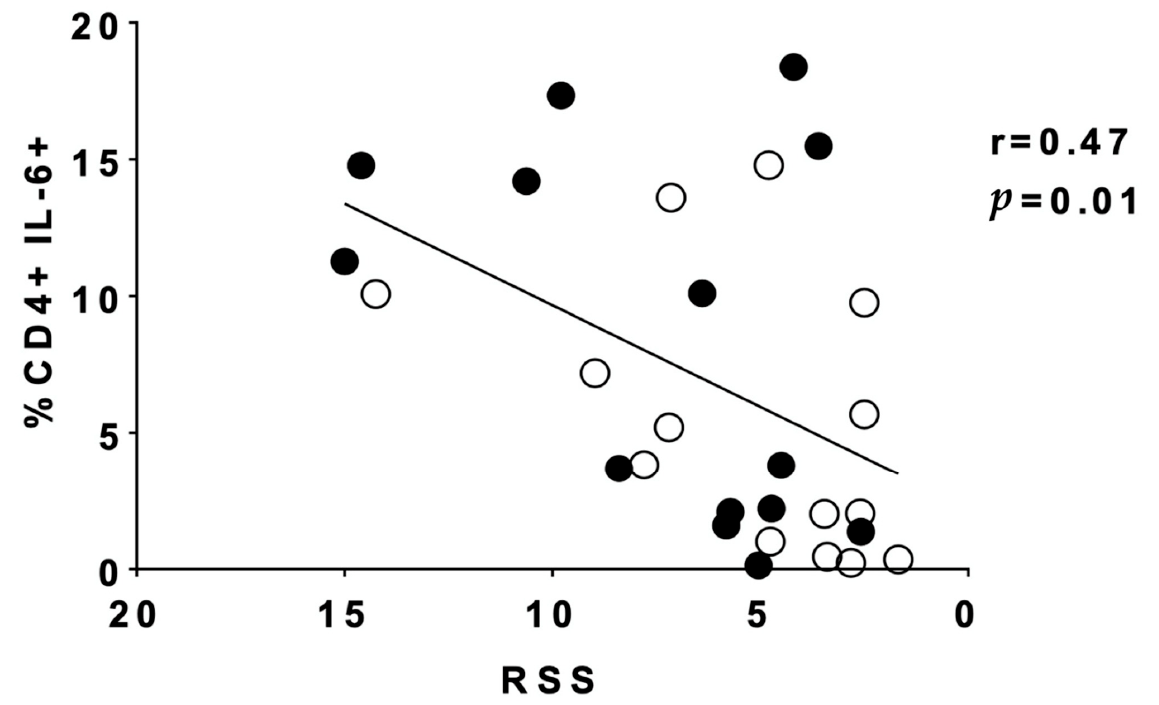
Figure 3. Tracheal aspirate (TA) cell phenotype of CD4+IL-6+ cells was significantly correlated with respiratory severity score (RSS, MAP × FiO2). As RSS decreased, the percent of CD4+IL-6 cells decreased, suggesting alterations in inflammation represented by CD4+IL-6+ expression are important for clinical respiratory status. Infants had TA obtained up to 72 h prior to initiation of the 10-day dexamethasone course and then a subsequent TA collection 1 to 3 calendar days after dexamethasone was initiated. n = 14. RSS was calculated on day 0 prior to dexamethasone initiation and 72 h later. Correlation was measured by Pearson’s correlation. Black circles indicate samples pre-dexamethasone. Open circles indicate samples post-dexamethasone.